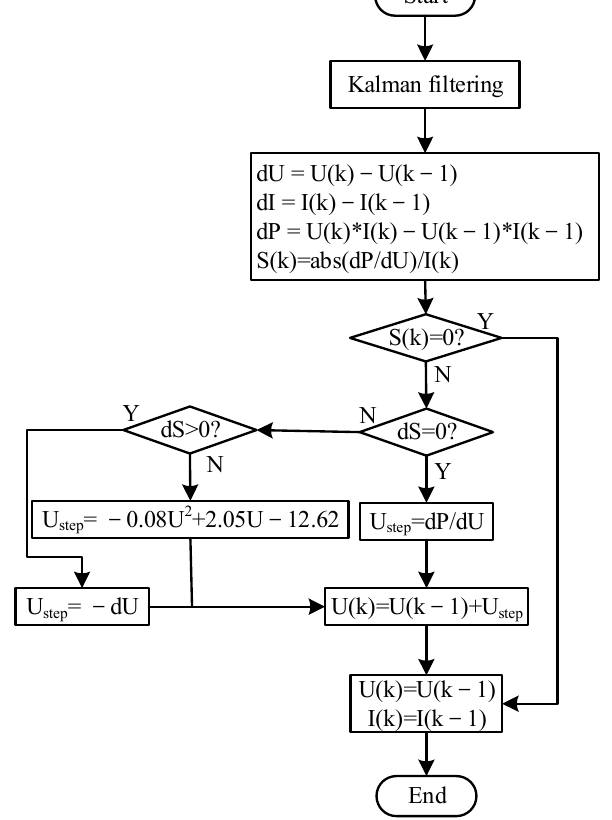
Figure 14. Improving variable step MPPT control algorithm process.